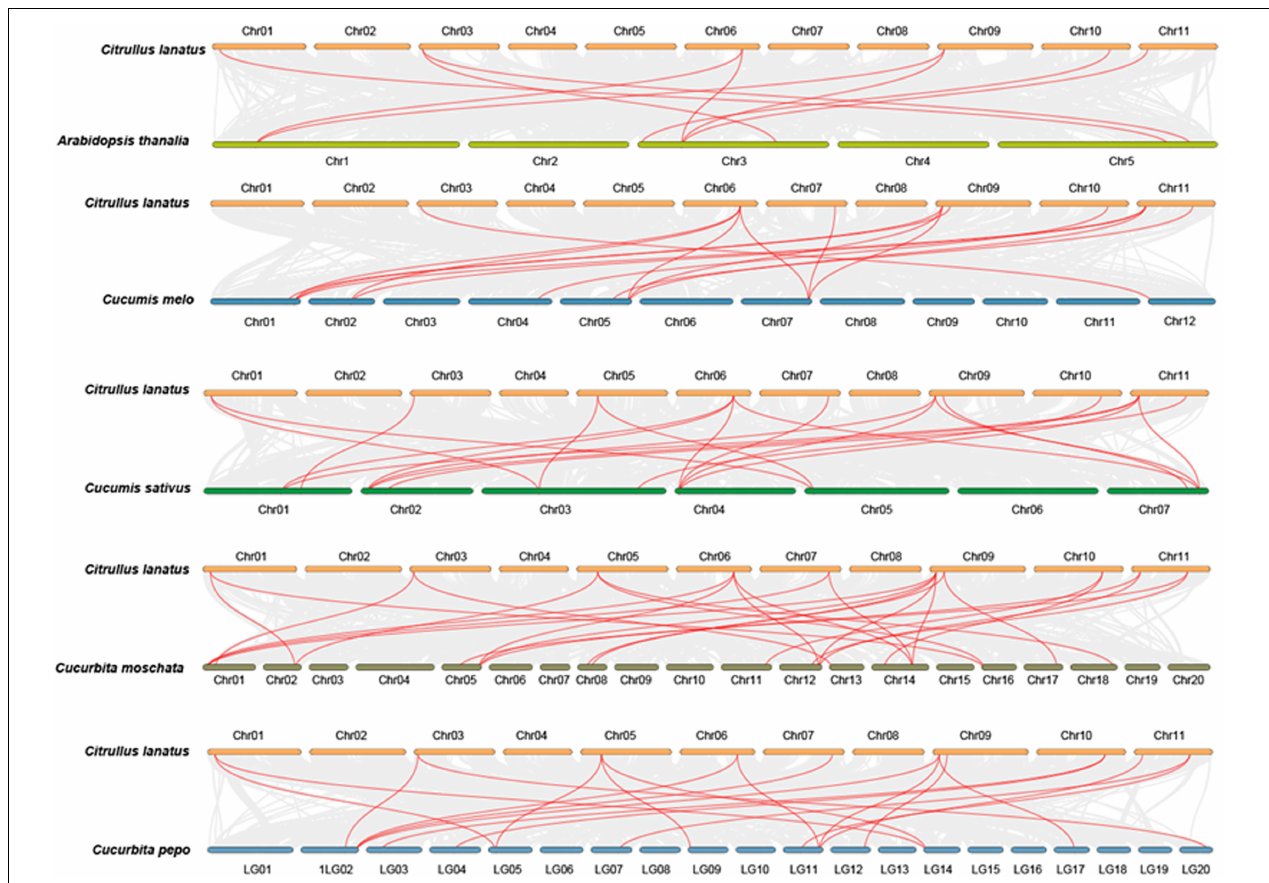
FIGURE 2 | Syntenic relationships of the watermelon ClMBD genes with other MBD genes in representative plant species. Gray lines in the background indicate the collinear blocks within the watermelon and other plant genomes, while the red lines highlight the syntenic MBD gene pairs between watermelon and other plant